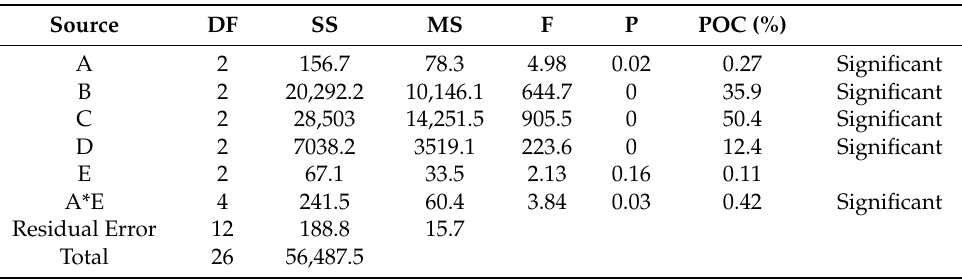
Table 7. ANOVA for cutting force.